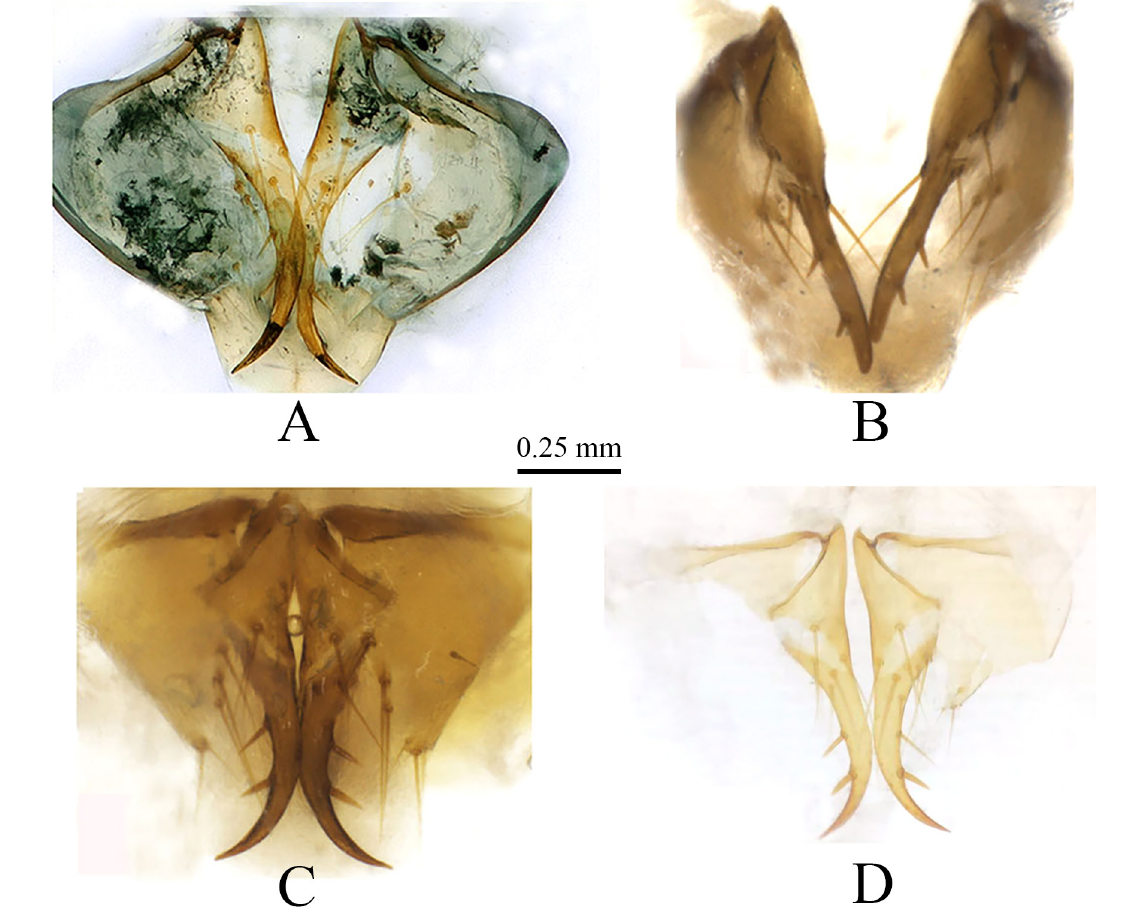
Fig. 10. Female genitalia of species of Guiodytes Tian, 2013, ventral view. A . G. deharvengi